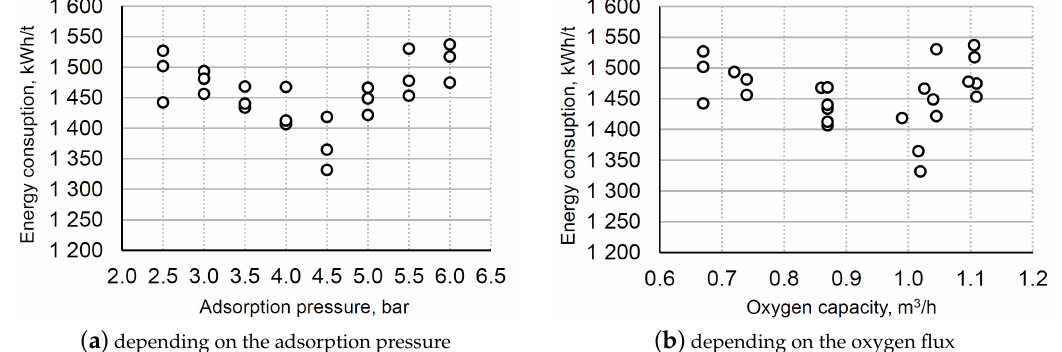
Figure 7. Optimized oxygen separation energy